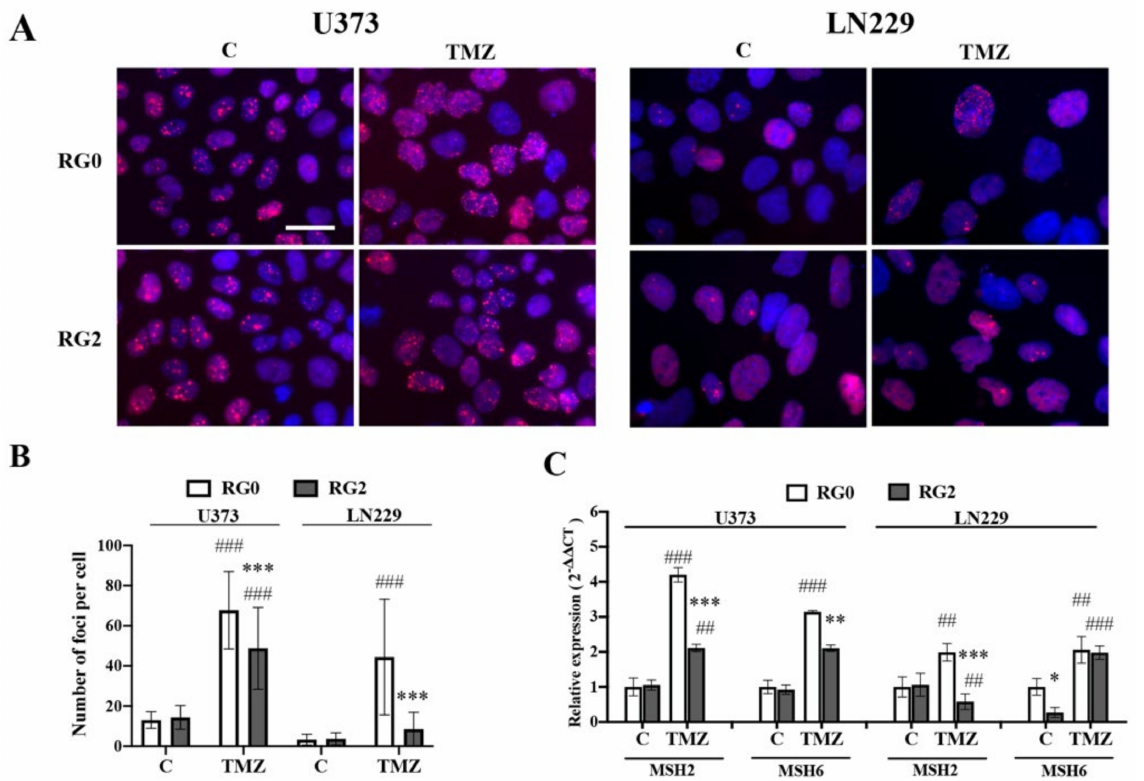
Figure 4. RG2 cells show less DNA damage in individual cells after challenge with TMZ, which was associated with the downregulation of MMR gene expression. 53BP1::mCherry-transfected U373-RGs and -LN229-RGs were treated with TMZ (150 µ M) or vehicle. DNA double-strand breaks (DSBs) and the expression of MMR genes were evaluated 72 h after treatment. ( A ) Representative images show the accumulation of DSBs as evidenced by the 53BP1-foci in U373-RGs and LN229-RGs. Scale bar: 30 µ m. ( B ) Quantitative analysis of accumulated 53BP1-foci. The number of 53BP1-foci was counted in 100 individual cells per group. ( C ) Downregulation of MSH2 and MSH6 genes in RG2 cells detected by RT 2 -PCR. *, p < 0.05; **, p < 0.01; ***, p < 0.001, compared with RG0. ##, p < 0.01; ###, p < 0.001, compared with a corresponding vehicle control